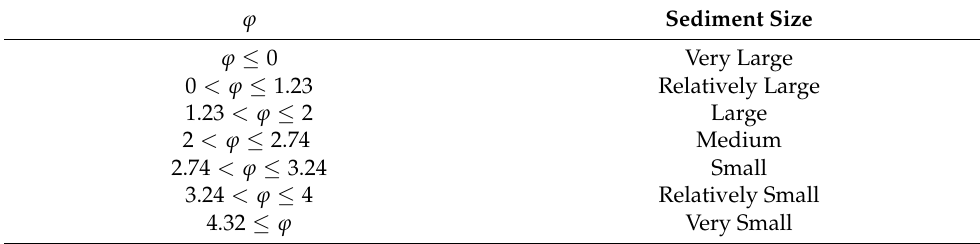
Table 6. Sediment size and associated ϕ